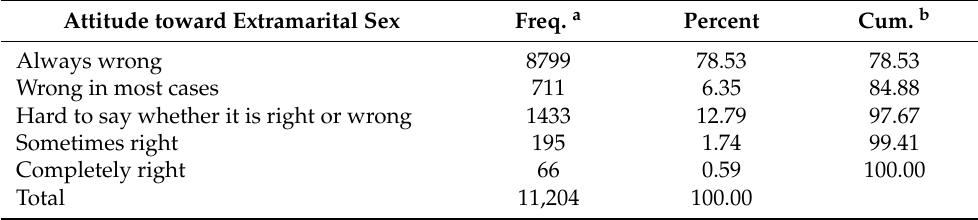
Table 1. Distribution of attitudes toward extramarital